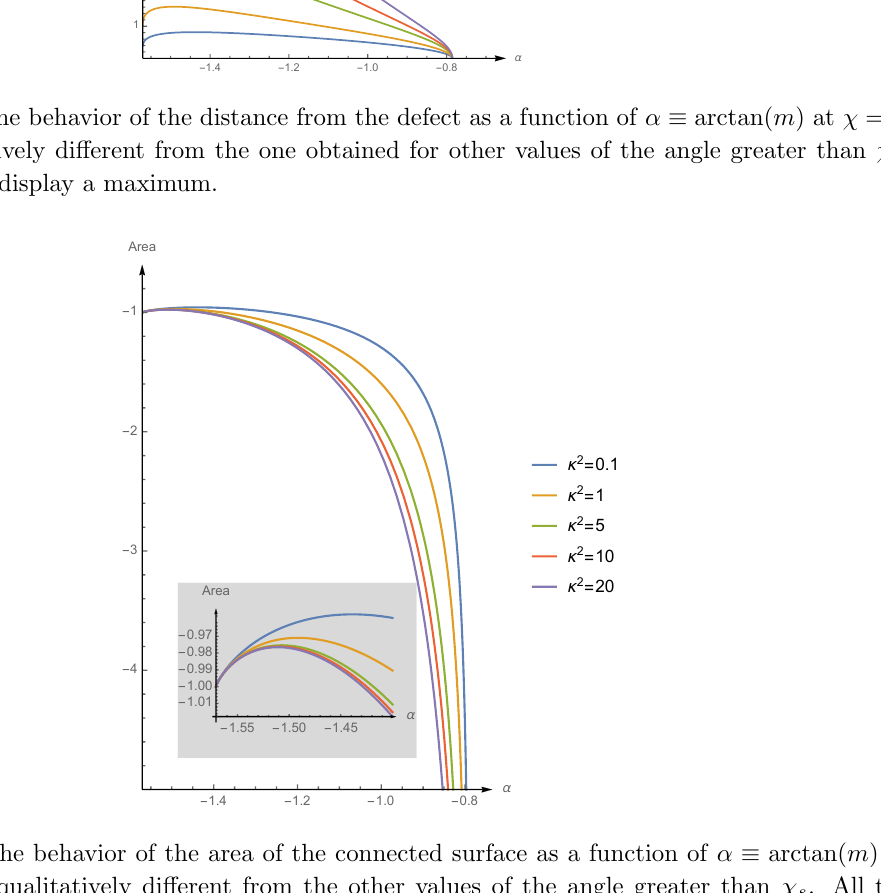
Figure 15. The behavior of the area of the connected surface as a function of (cid:11) (cid:17) arctan( m ) at (cid:31) = (cid:25) is not qualitatively di(cid:11)erent from the other values of the angle greater than (cid:31) s . All the 2 curves display a